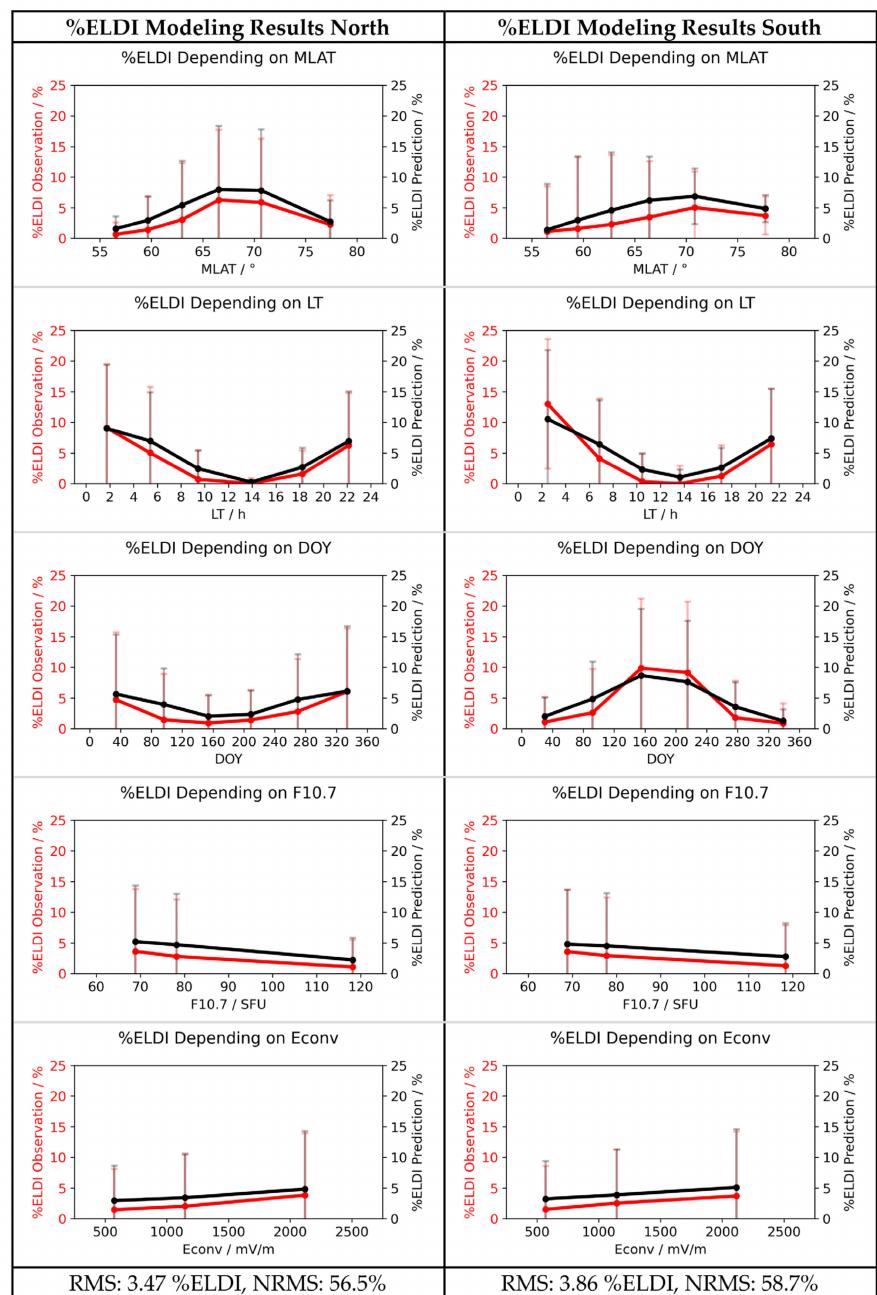
Figure 5. Observed (red) and predicted (black) %ELDI trends for the modeling dataset. ( Left ) North- ern Hemisphere. ( Right ) Southern Hemisphere. Last row: RMS and NRMS deviation between observation and